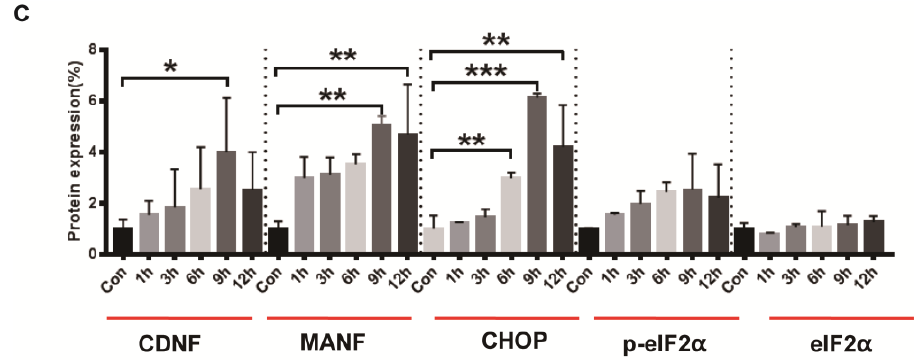
Figure 5. The expression of CDNF in cultured primary neurons treated with an ER inducer. ( A ) CDNF (red)/CHOP (green) double labeling in the primary neurons. The cells were treated with vehicle or tunicamycin (2.5 or 10 μg/mL) for 4 h before staining. DAPI (blue) labeled all the nuclei. Scale bar = 45 μm. The insets show photomicrographs of the primary neurons at higher magnification. Scale bar=25μm. ( B ) The representative Western blotting to show the expression of CDNF and ER markers. The primary neurons were treated with 2.5 μg/mL of tunicamycin for 1, 3, 6, 9 and 12 h before being collected. Tubulin was used as a loading control; MANF as the positive control. ( C ) Protein levels were quantified as relative levels compared to Tubulin, three independent experiments were performed and the reported data represent the mean of the three experiments, one-way ANOVA, * p < 0.05, ** p < 0.01 and *** p < 0.001.